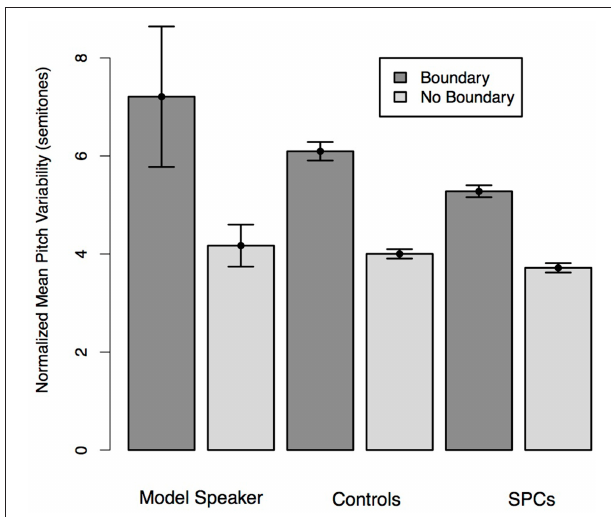
FIGURE 9 | Normalized pitch variation of words preceding hypothesized boundary locations and non-boundary locations in the Unambiguous Coordinate Structure sentences as produced by the Model Speaker, Controls, and SPCs. Error bars represent standard